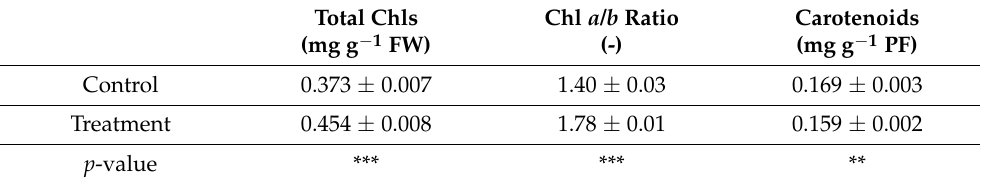
Table 3. Total Chls and carotenoid concentrations in control plants and plants treated with Archer ®